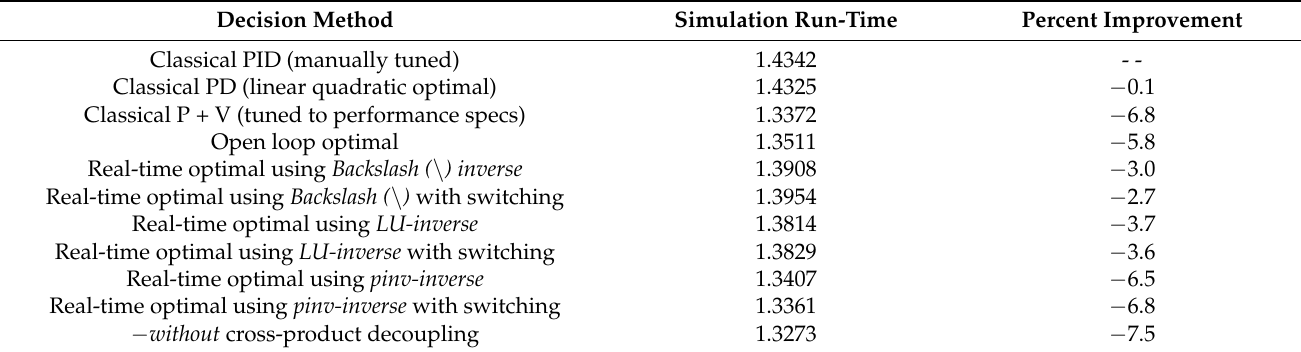
Table 12. Simulation run-time